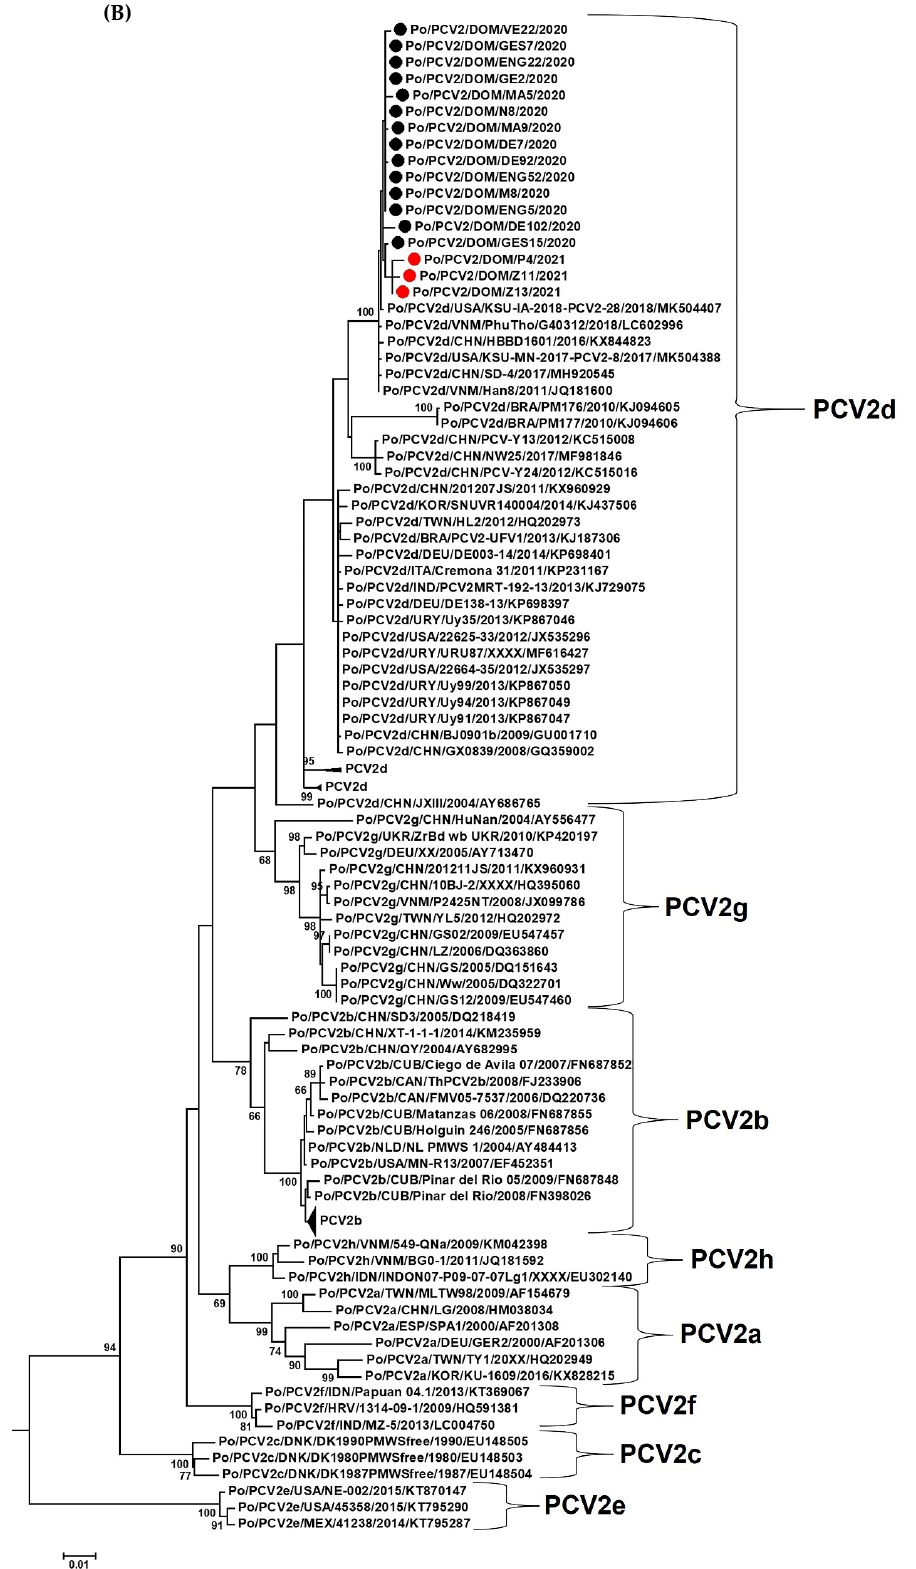
Figure 2. Phylogenetic analyses of the nucleotide sequences of open reading frame 2 ( A ) and complete genomes ( B ) of porcine circovirus 2 (PCV2) strains from the Dominican Republic with those of